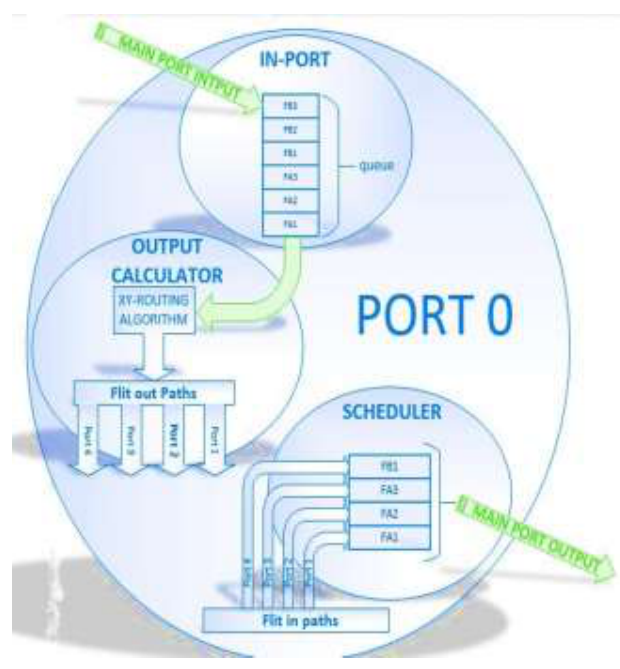
Figure 5. A single